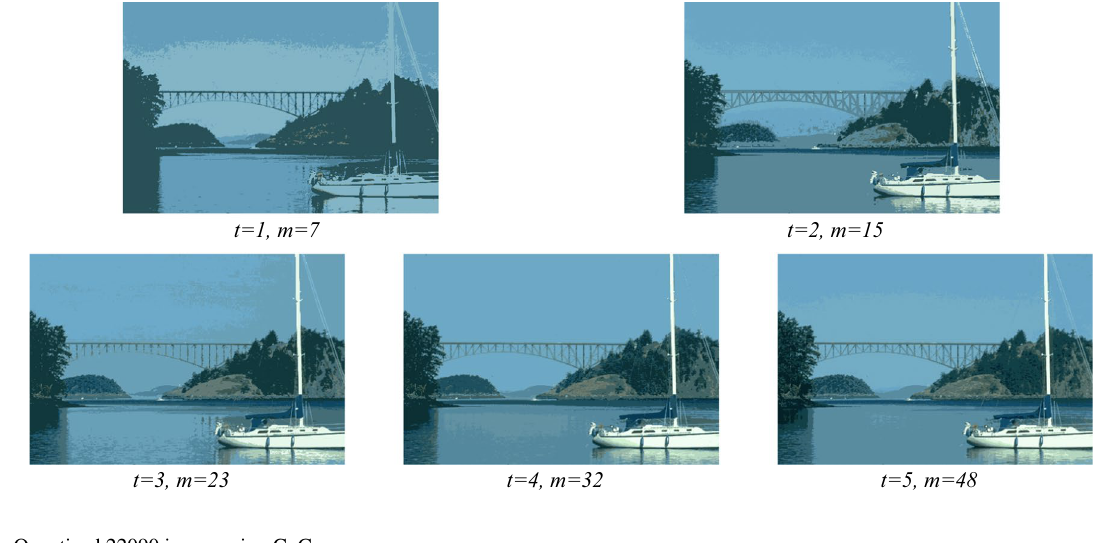
Fig. 10 Quantized 22090 image using CoG